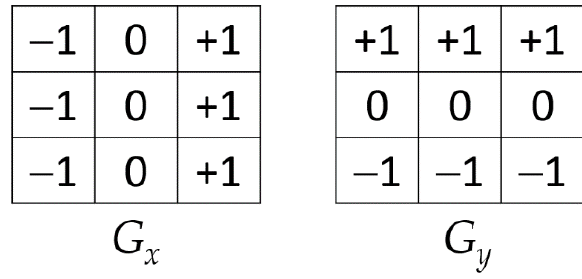
Figure A5. 3 × 3 masks of